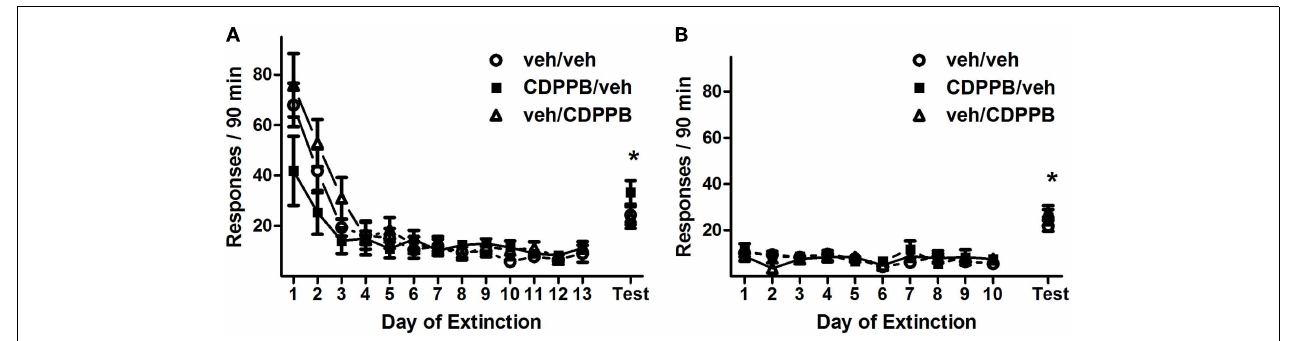
during the second extinction phase, followed by the final cue reinstatement test session. Filled symbols indicate pretreatment with 30mg/kg CDPPB on Days 1–7, and open symbols indicate corresponding vehicle treatment. * p < 0.05 difference between reinstatement testing and average of final two extinction sessions, in all treatment groups (paired t